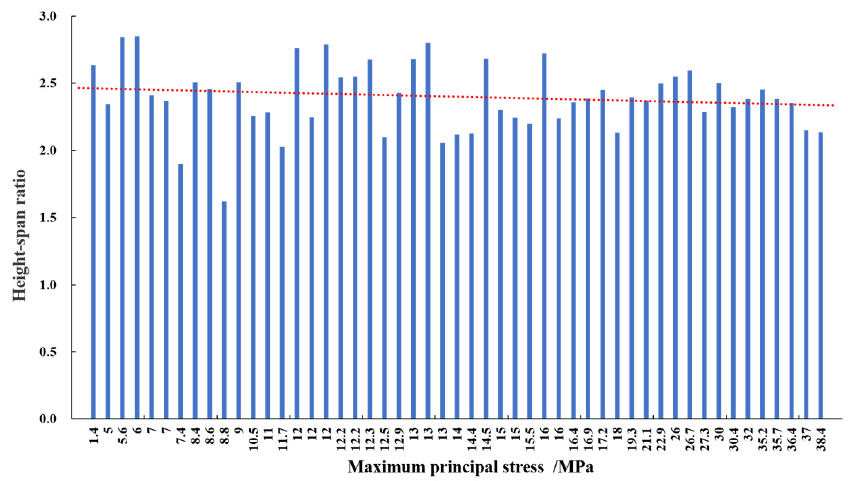
Figure 29. The relationship between height–width ratio of underground powerhouse and in situ stress level. stress